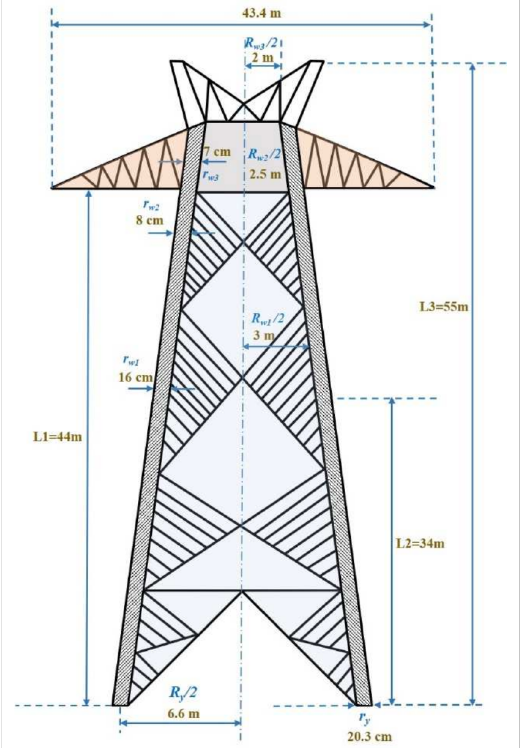
Figure 4. Geometry and dimensions of the 500 kV DC transmission tower